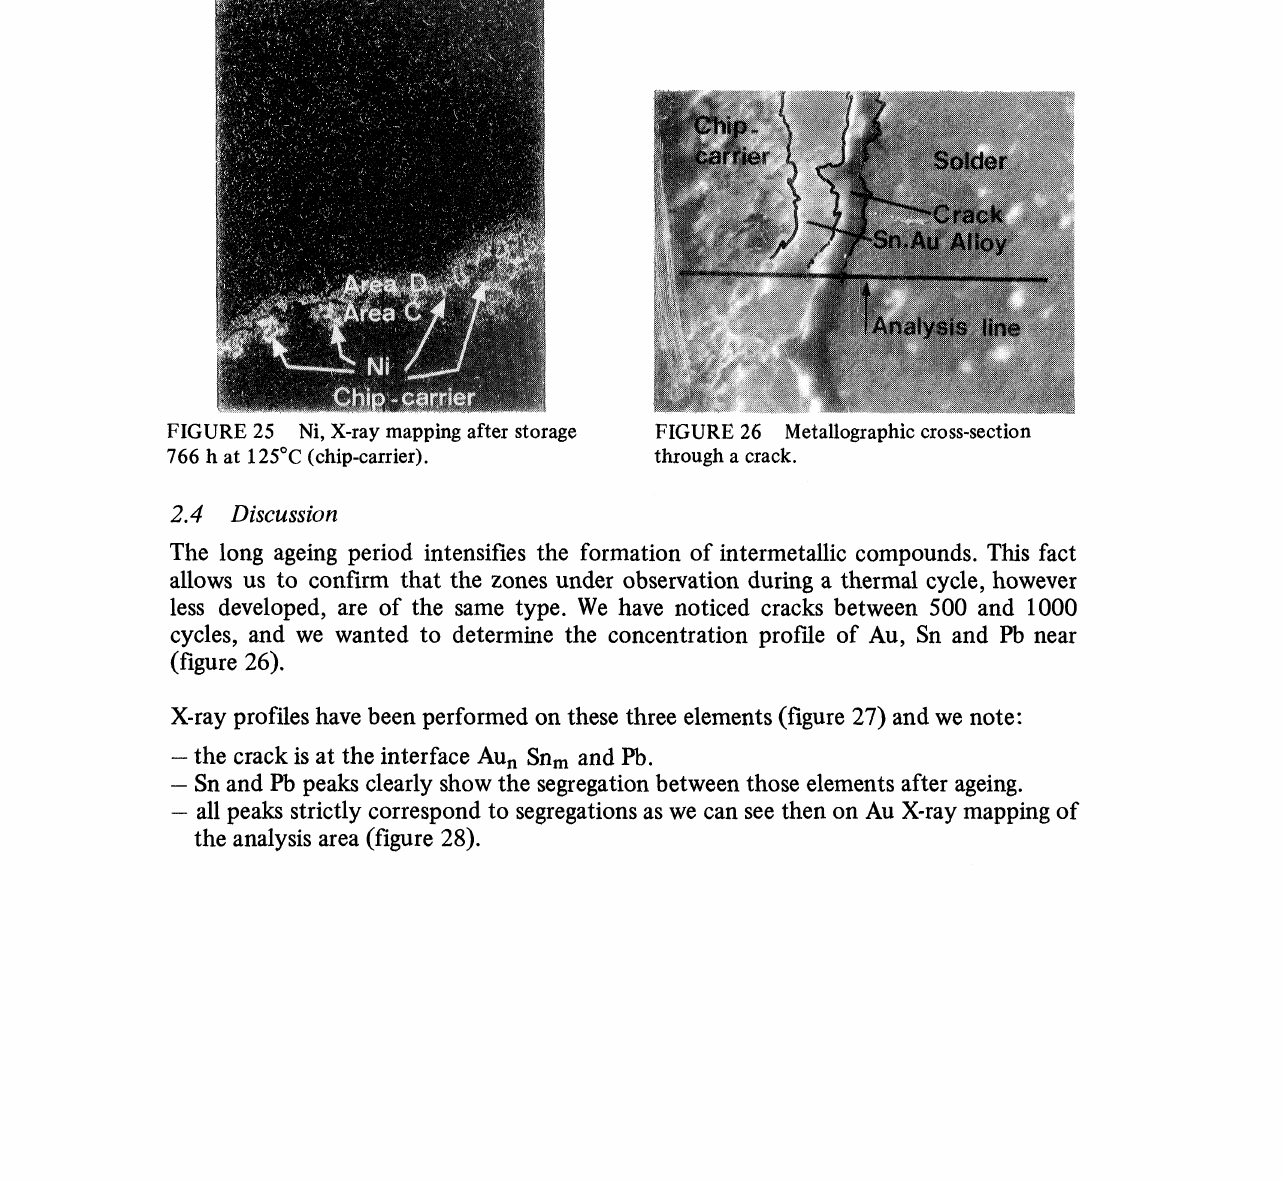
FIGURE 23 Pb, X-ray mapping after storage 766 h at 125C (chip-carrier).